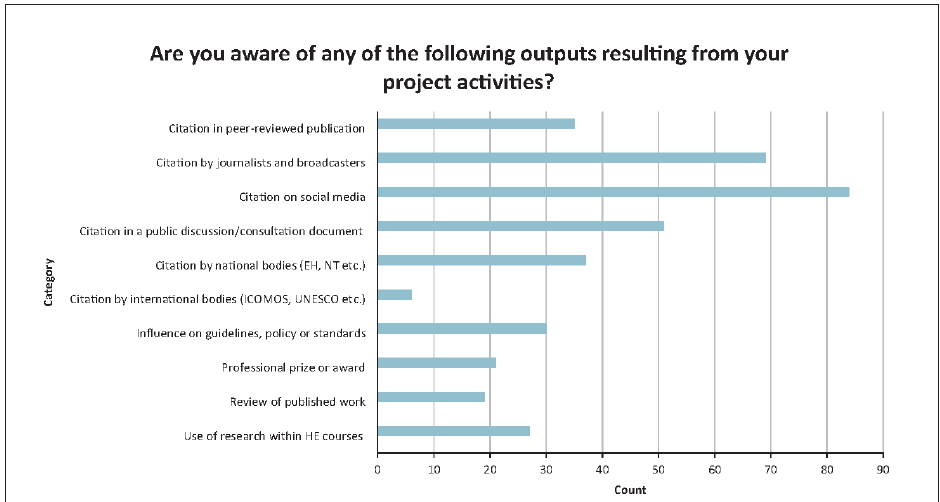
Fig. 5: The value of commercial practice as research. Categories adapted from REF (2014: 72). Source of data: National Survey on Public Engagement in Commercial Archaeology May- June 2013, n=181 (© Hilary